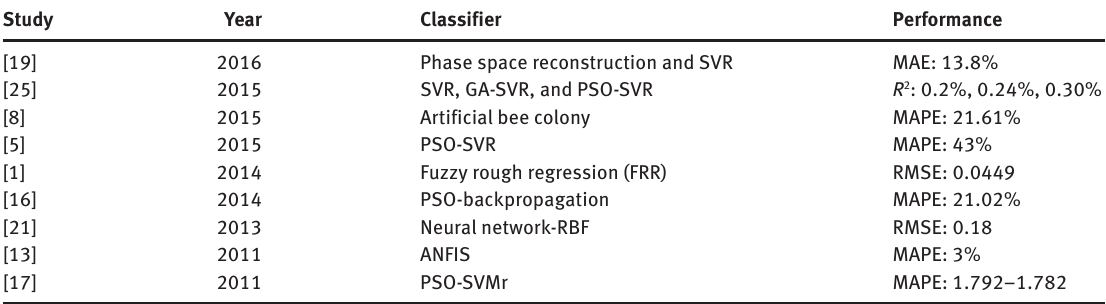
Table 3: Comparison of the Maximum Performance Evaluation Obtained by the Proposed Approach and Other Existing Methods. Study Year Classifier